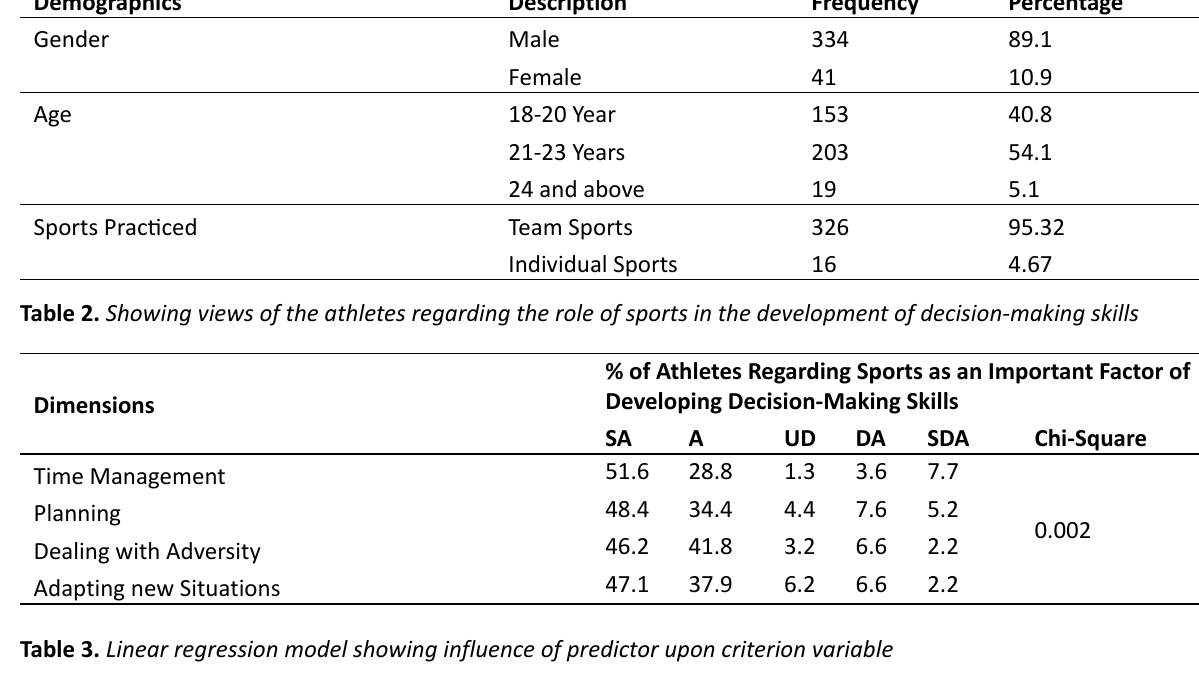
Table 1. Demographics characteristics of participants (n=375) Demographics